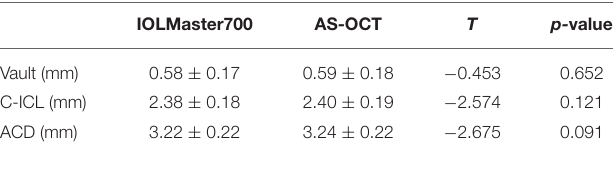
TABLE 3 | Comparison of parameters measured using the IOL Master700 and AS-OCT.